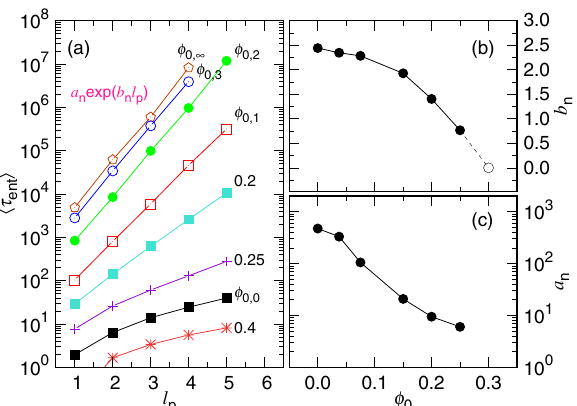
τ ent Figure 12. ( a ) as a function of ℓ p in the semi-log plot. The value of φ 0 is given near the corresponding (cid:31) (cid:30) curve. The data are fit by non-linear regression method via the form a n exp ( b n ℓ p ) for φ 0 > φ p . ( b ) b n vs. φ 0 . ( c ) a n vs. φ 0